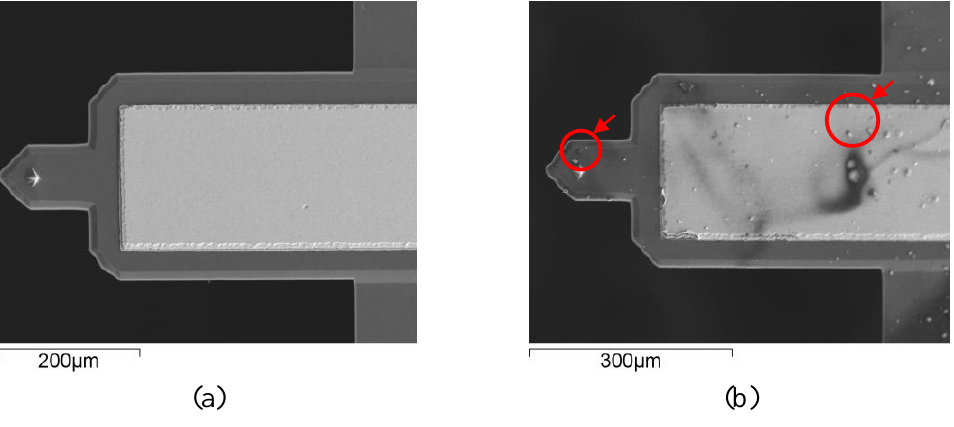
Figure 6. Scanning electron micrographs of the micro-cantilever: (a) Before the deposition of PEO sensitive material. (b) After the deposition of PEO sensitive